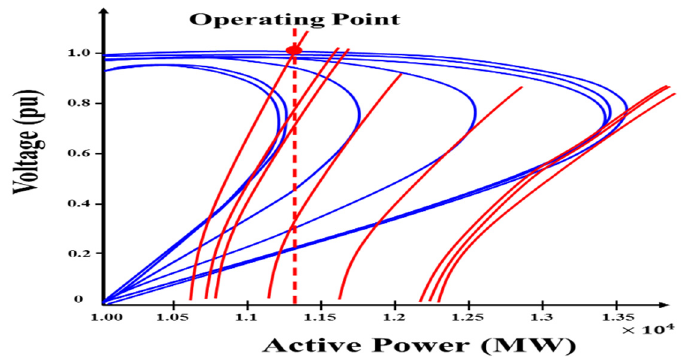
Figure 18. PV curves and load characteristic curves.